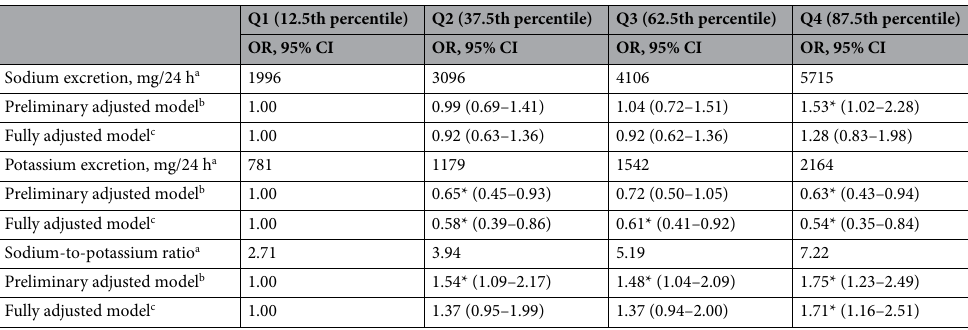
Table 4. Associations of 24-h urinary sodium and potassium excretion and their ratio with hypertension. Here, hypertension status was a binary variable (hypertension and non-hypertension), and binary logistic regression analysis was performed. *Indicates P < 0.05. a These rows contain the estimated mid-value of quartiles in the population. b Preliminary adjusted model included age, sex, and ethnicity. c Fully adjusted models included age, sex, ethnicity, education, body mass index, history of cardiovascular disease, mellitus status, chronic kidney disease, smoking status, alcohol use status and physical activity. In addition, models examining sodium excretion were simultaneously adjusted for potassium excretion, and vice versa.